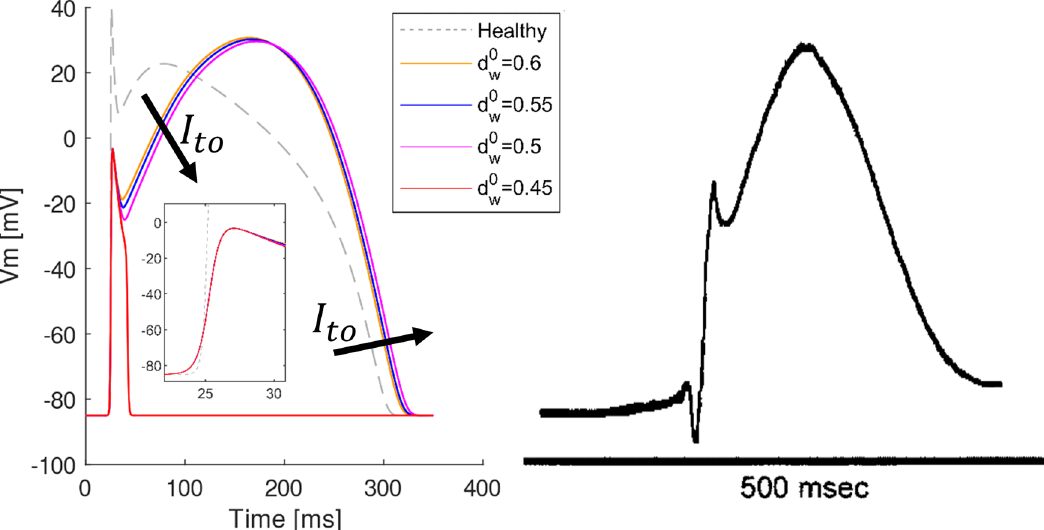
0 w ; 0 w ); the inset zooms on